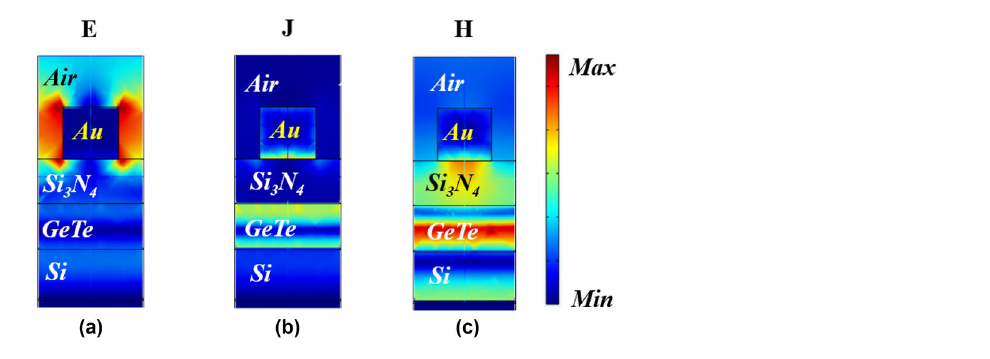
Figure 8. Spatial distribution of ( a ) normalized electric field; ( b ) normalized current density and; ( c ) normalized magnetic field of the absorber on resonant wavelength at 1550 nm and m =